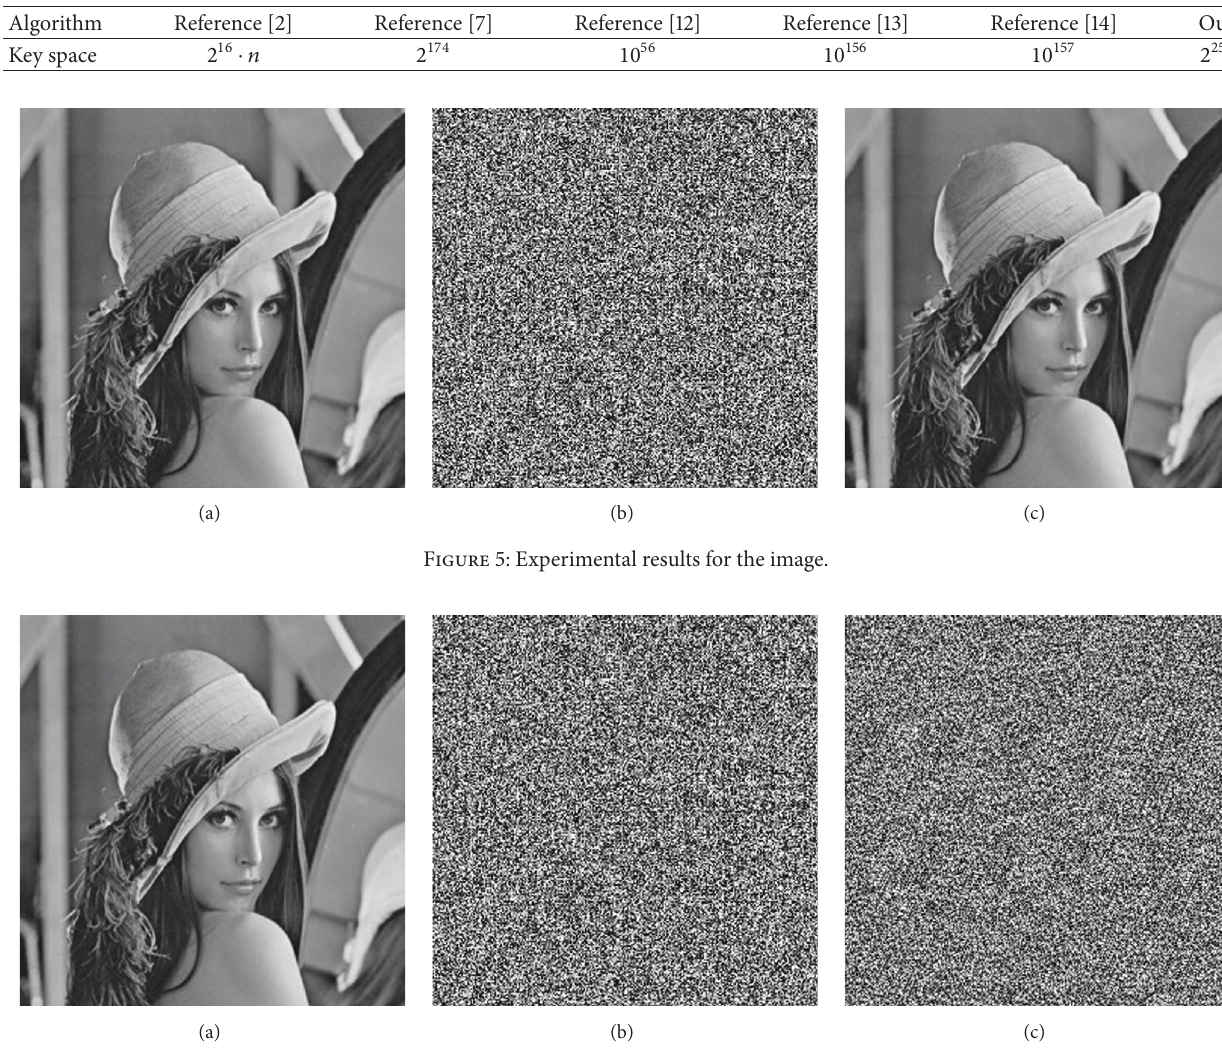
Table 3: Comparison of key spaces.